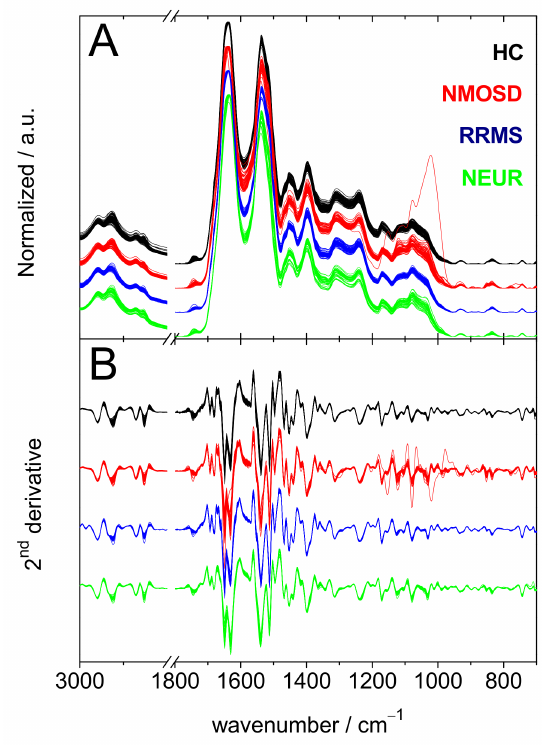
Figure 1. Infrared data of the 235 serum samples included in this study. ( A ) Normalized Fourier- transform infrared (FTIR) spectra of all serum samples in the 3000–2800 and 1800–700 cm − 1 spectral ranges. ( B ) Second derivatives of the spectra of panel A. Healthy controls (black), neuromyelitis optica spectrum disorder (NMOSD) (red), relapsing-remitting multiple sclerosis (RRMS) (blue) and peripheral neuropathies (NEUR) (green). The groups of spectra and derivatives are off-set for